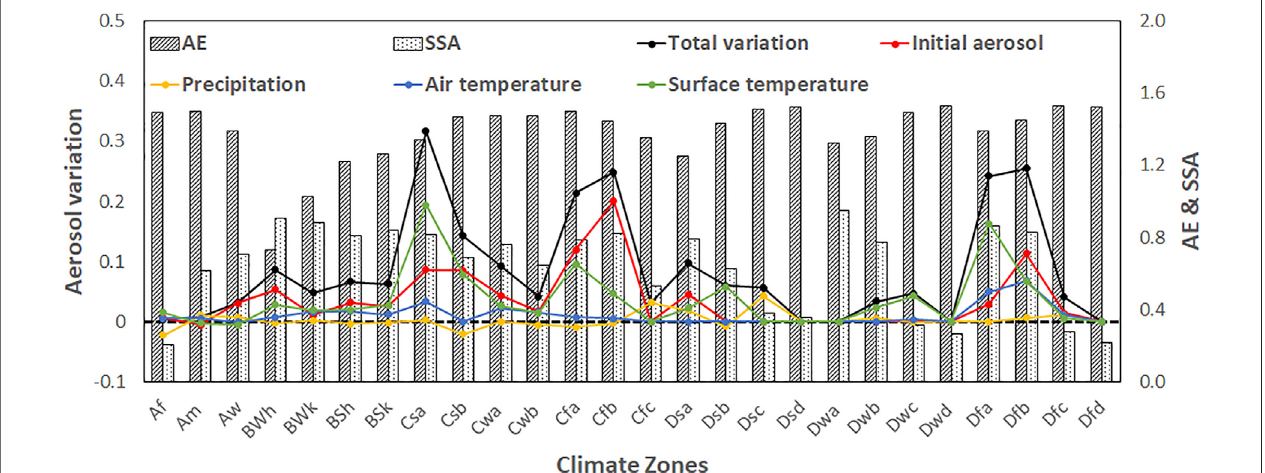
FIGURE4| Statisticsofaerosolvariationandcharacteristicsindifferentclimatezones.Thepixelwisevariationisupscaledbytheareaweightedineachclimatezone ( λ c (cid:2) λ · S c , where λ and S c are the mean pixelwise variation and its area ratio to the total area of the climate zone, respectively). The labels for the climate regions are composed of two or three letters. The fi rst letter refers to the climate type, tropical (A), arid (B), temperate (C) and cold (D). The second letter indicates the precipitation condition: rainforest (F), monsoon (M) and savannah (S) in tropical climates, desert (W) and steppe (S) in arid climates, dry summer (S), dry winter (w) and without a dry season (F) in temperate and cold climates. The third letter designates hot (H) or cold (K) in an arid climate and hot summer (a), warm summer (b), cold summer (c) or very cold summer (d) in temperate and cold climates. The de fi nitions of the climate zones can be seen in the reference of Peel et al (Peel et al., 2007).